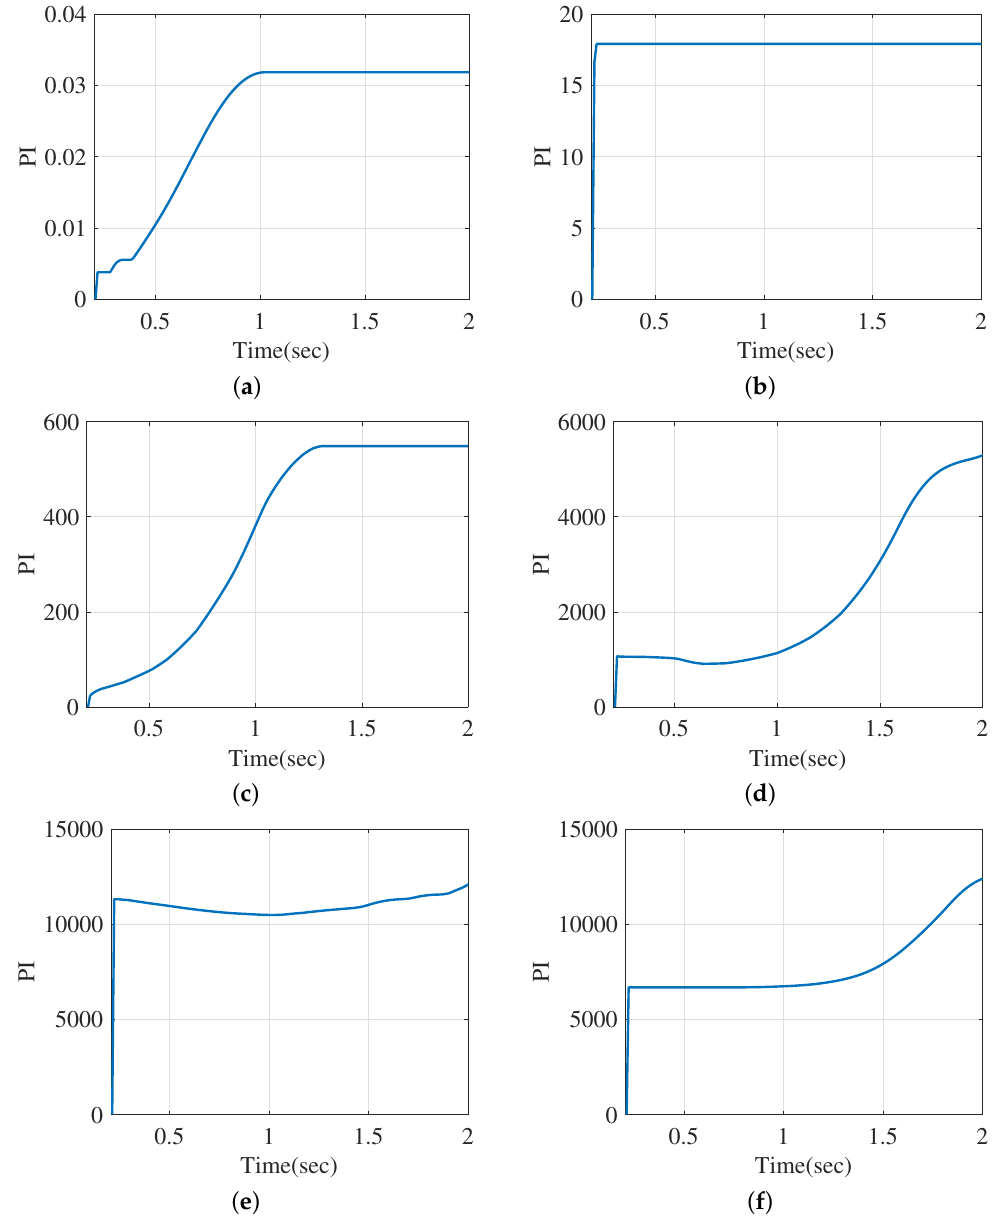
Figure 6. PI calculated for defined scenarios: ( a ) Case a, ( b ) Case b, ( c ) Case c, ( d ) Case d, ( e ) Case e, ( f ) Case